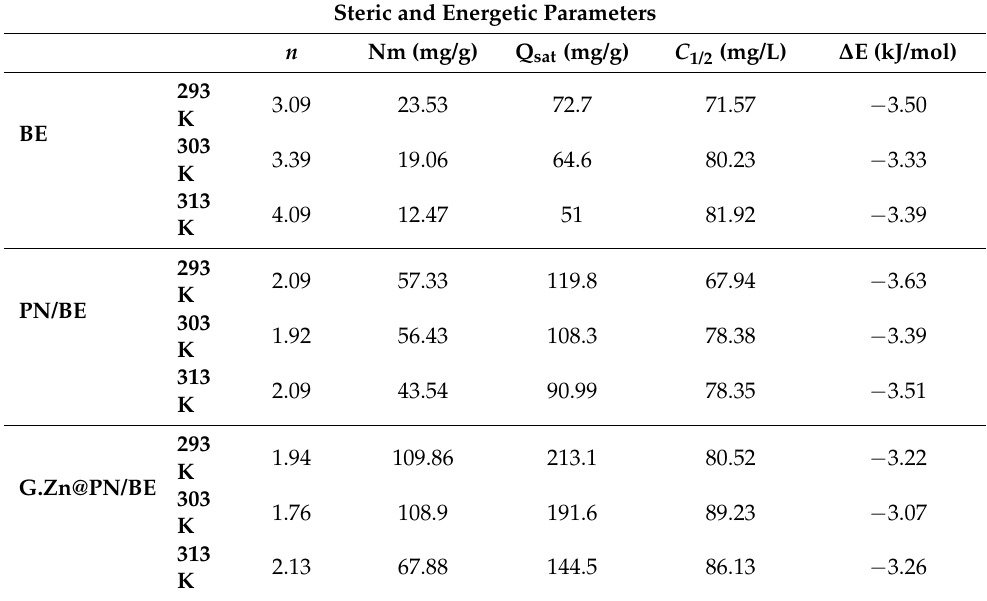
Figure 7. Fitting of the As (V) retention results by BE, PN/BE, and G.Zn@PN/BE with advanced monolayer model of one energy ( A – C ), the behavior of n parameter (number of adsorbed As (V) ions per site) at different temperature values ( D ), the behavior of Nm parameter (active sites density) at different temperature values ( E ), and the behavior of Q sat parameter (adsorption capacity at saturation) at different temperature values ( F ). Table 2. The estimated mathematical parameters for the fitting process with Monolayer model of one